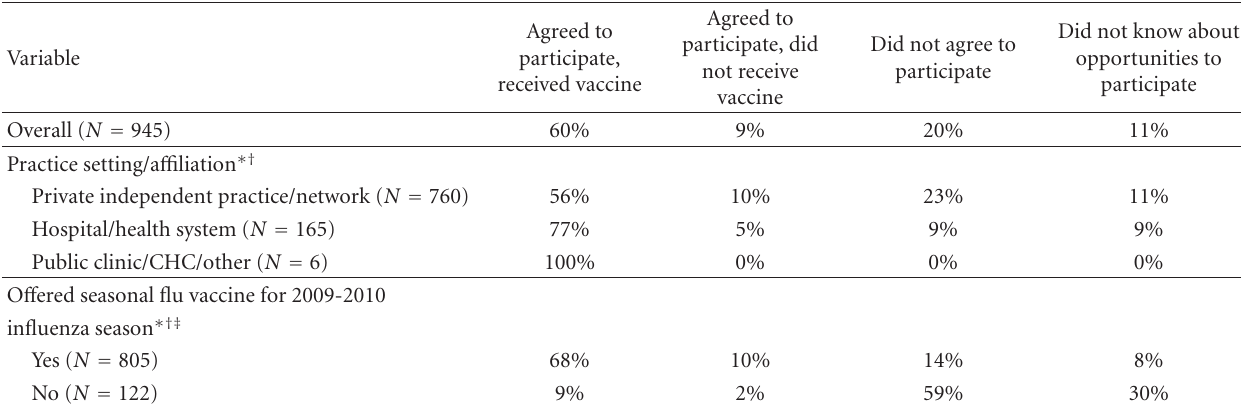
Table 3: H1N1 vaccinator status of pulmonologists and association with practice characteristics. Variable